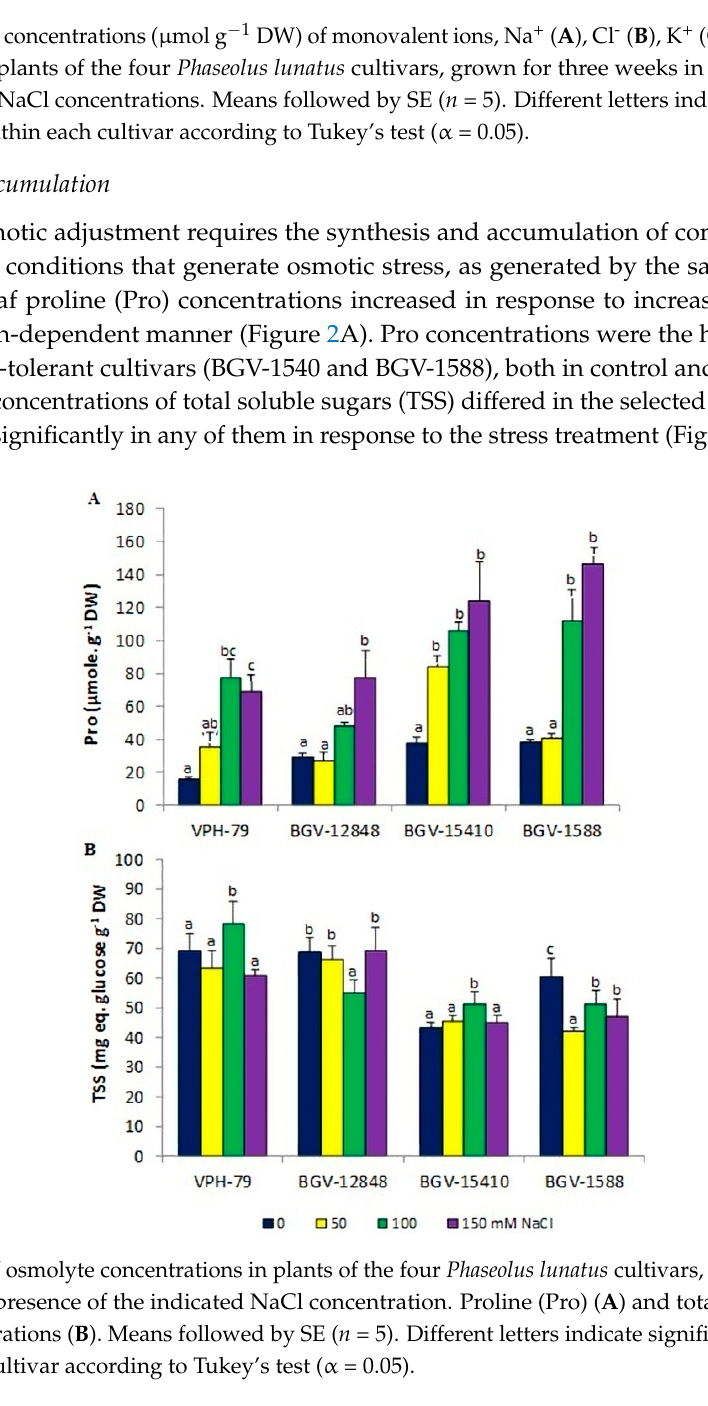
Figure 3. Principal component analysis (PCA). Changes in growth parameters, photosynthetic pigments monovalent ions, and osmolytes concentrations in plants growth under salt stress conditions for three weeks, with respect to the corresponding control, non-stressed plants of the four local cultivars of Phaseolus lunatus : VPH-79 (red), BGV-12848 (blue), BGV-15410 (green), and BGV 158 (grey). Squares surrounded by a box correspond to control treatments. The percentages of the total variability explained by the first two components are shown (in parentheses) on the X and Y axes, respectively. Abbreviations: EC, substrate electric conductivity; RL, root length; RFW, root fresh weight, RDW, root dry weight; RWC, root water content; SL, stem length; SD, stem diameter; SFW, stem fresh weight; SDW, stem dry weight; SWC, stem water content; Lno, leaf numbers; LFW, leaf fresh weight; LDW, leaf dry weight; LWC, leaf water content; TFW, total fresh weight; Chl a, chlorophyll a; Chla b, chlorophyll b; Caro, carotenoids; Na, sodium; K, potassium; Cl, chlorine; Pro, proline; TSS, total soluble sugars.